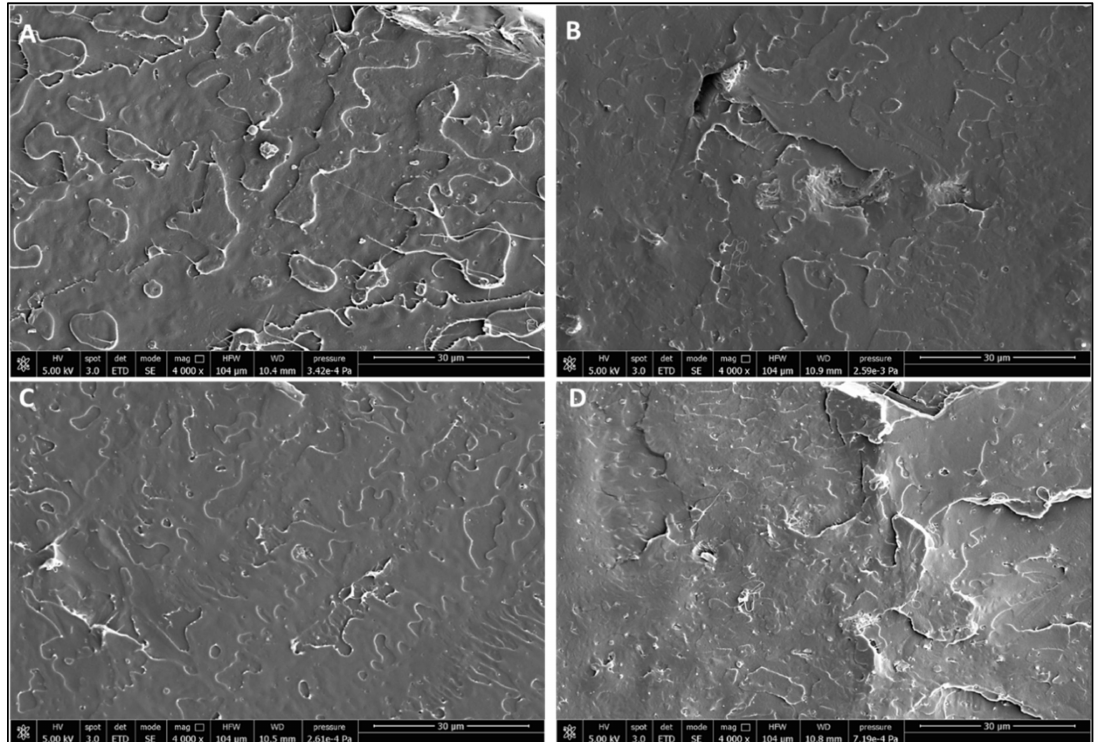
Figure 7. SEM micrographs of PLA_PEG_10_EX ( A ), PLA_OLA_10_CE ( B ), PLA_PEG_10_EX ( C ), and PLA_OLA_10_CE ( D ) at a magnification of 4000 ×